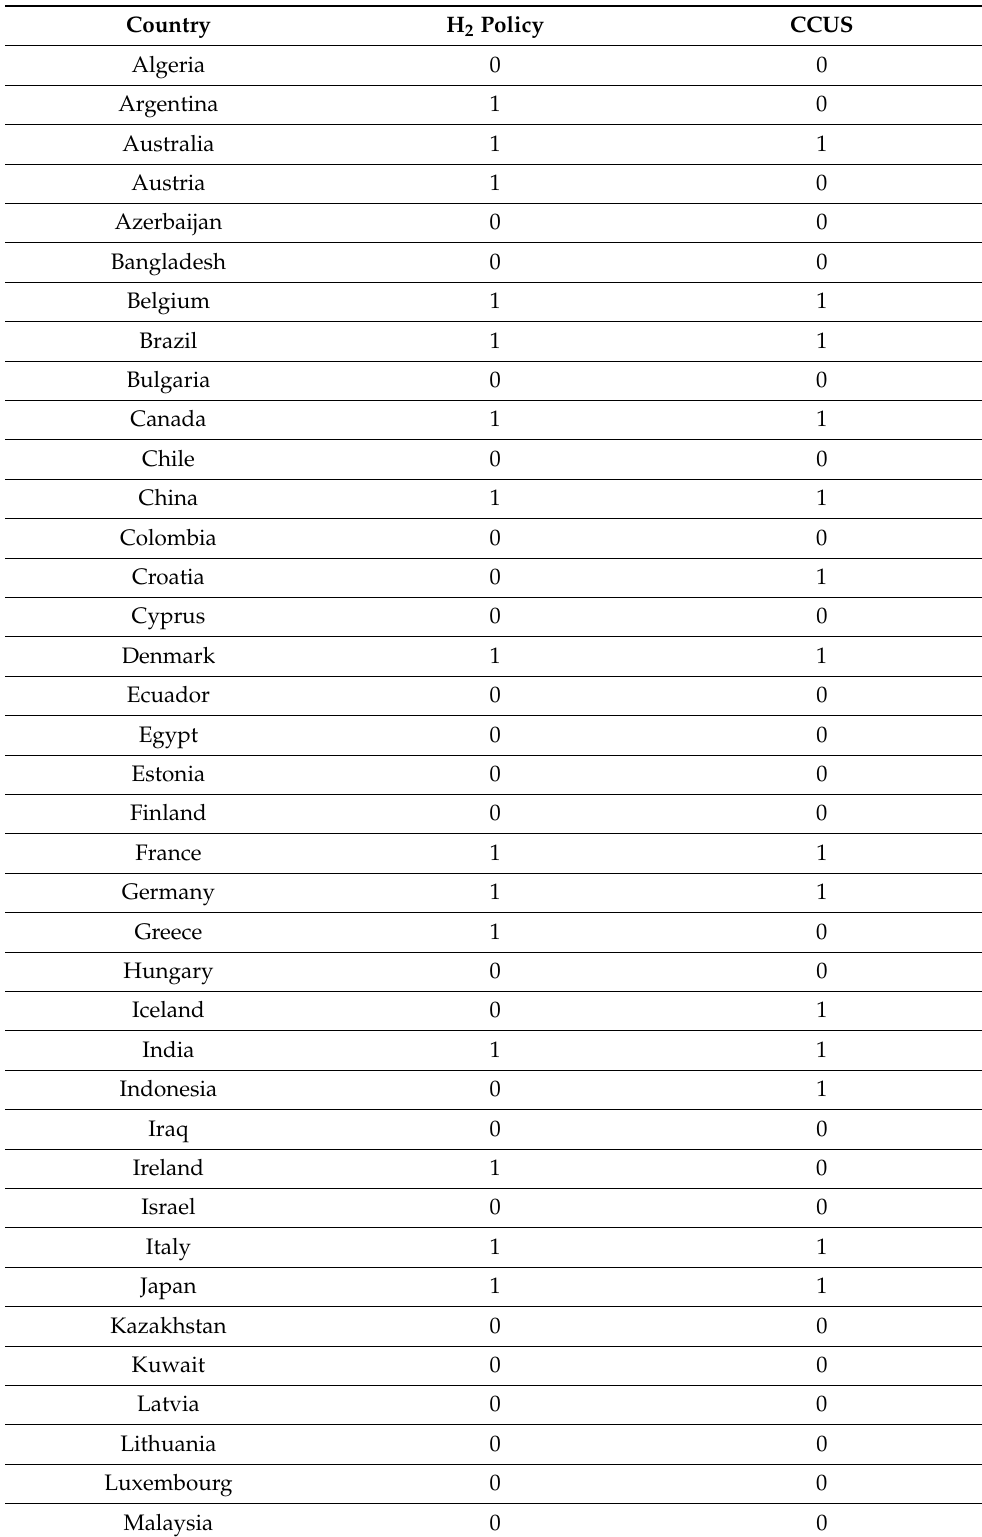
Table 1. Countries overview for the binary dependent